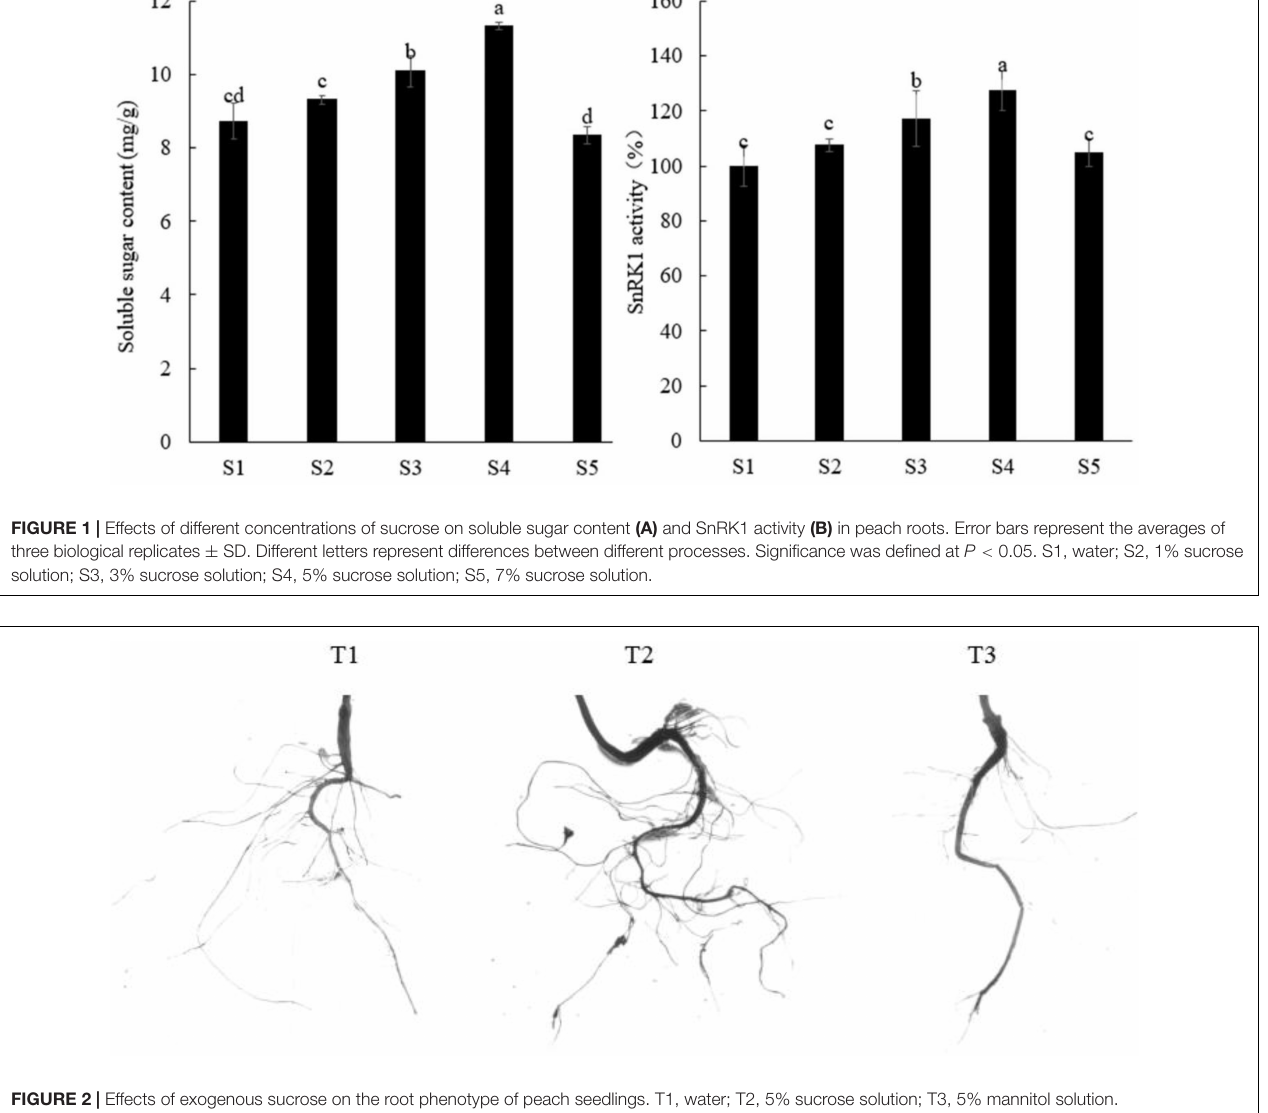
FIGURE 2 | Effects of exogenous sucrose on the root phenotype of peach seedlings. T1, water; T2, 5% sucrose solution; T3, 5% mannitol solution. TABLE 2 | Effects of exogenous sucrose on the root architecture of peach